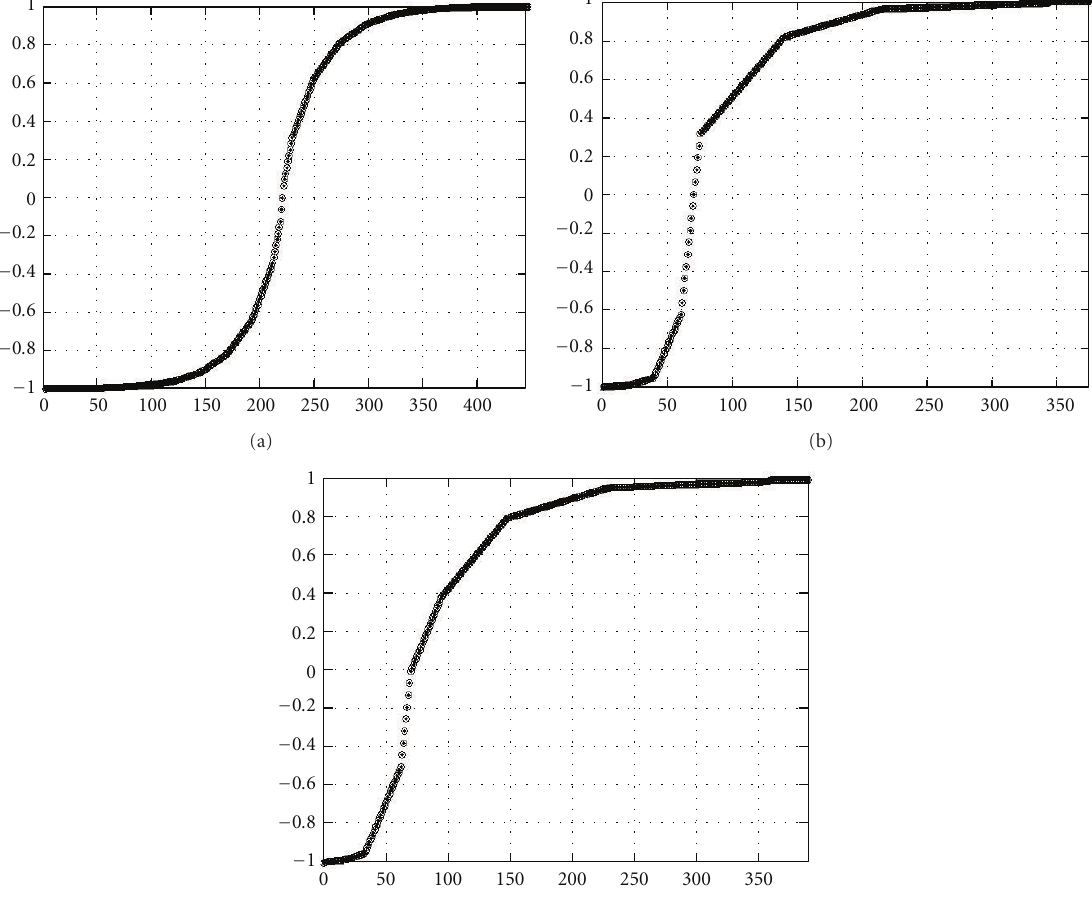
obtained with the sampling schemes α (a), β (b), and γ m